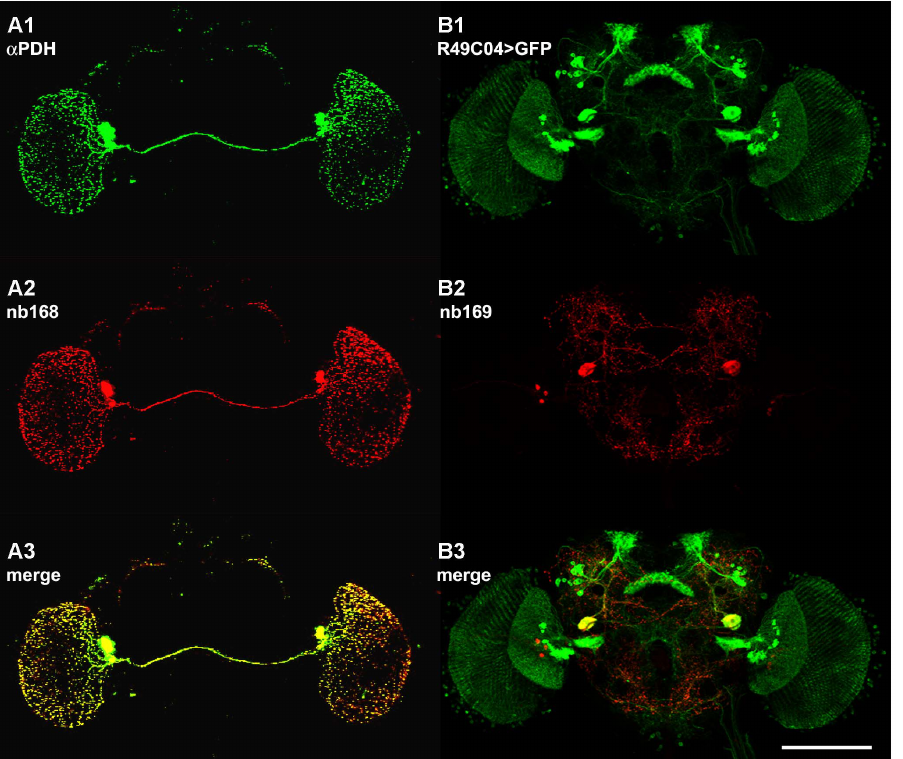
Figure 3. Z-projections of confocal stacks of whole-mount brains double-stained with mAb nb168 and anti-PDH antiserum (A1-3) or mAb nb169 and anti-GFP in a fly expressing GFP driven by Janelia Gal4 line R49C04 (B1-3). The perfect co-localization in A3 indicates that nb168 could recognize Drosophila PDF or its precursor protein, whereas co-localization in B3 is restricted to the two very large cells stained by nb169 in the posterior protocerebrum. Scale bar 100 m m.